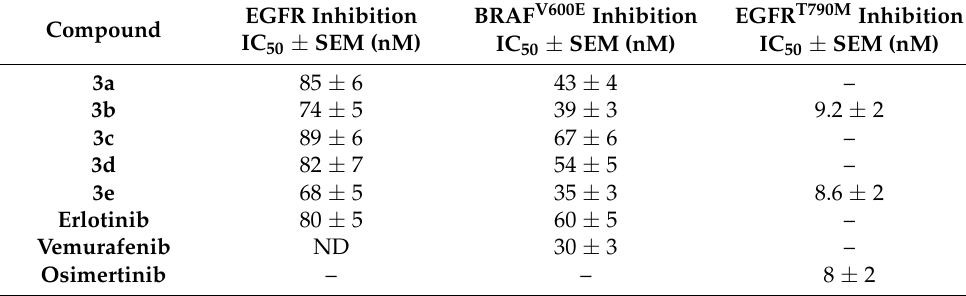
Table 2. IC 50 of compounds 3a–e against EGFR and BRAF V600E